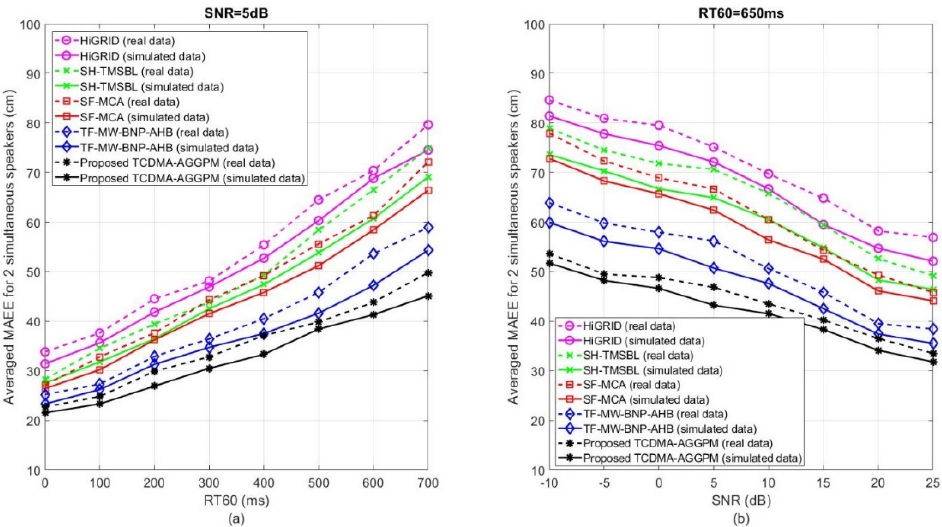
Figure 6. The averaged MAEE results (in cm) for the proposed TCDMA-AGGPM algorithm in comparison with HiGRID, SH-TMSBL, SF-MCA, and TF-MW-BNP-AHB methods, for 2 simultaneous speakers on real and simulated data, ( a ) for SNR = 5 dB and 0 ≤ RT 60 ≤ 700 ms, and ( b ) for RT 60 = 650 ms and − 10 dB ≤ SNR ≤ 25